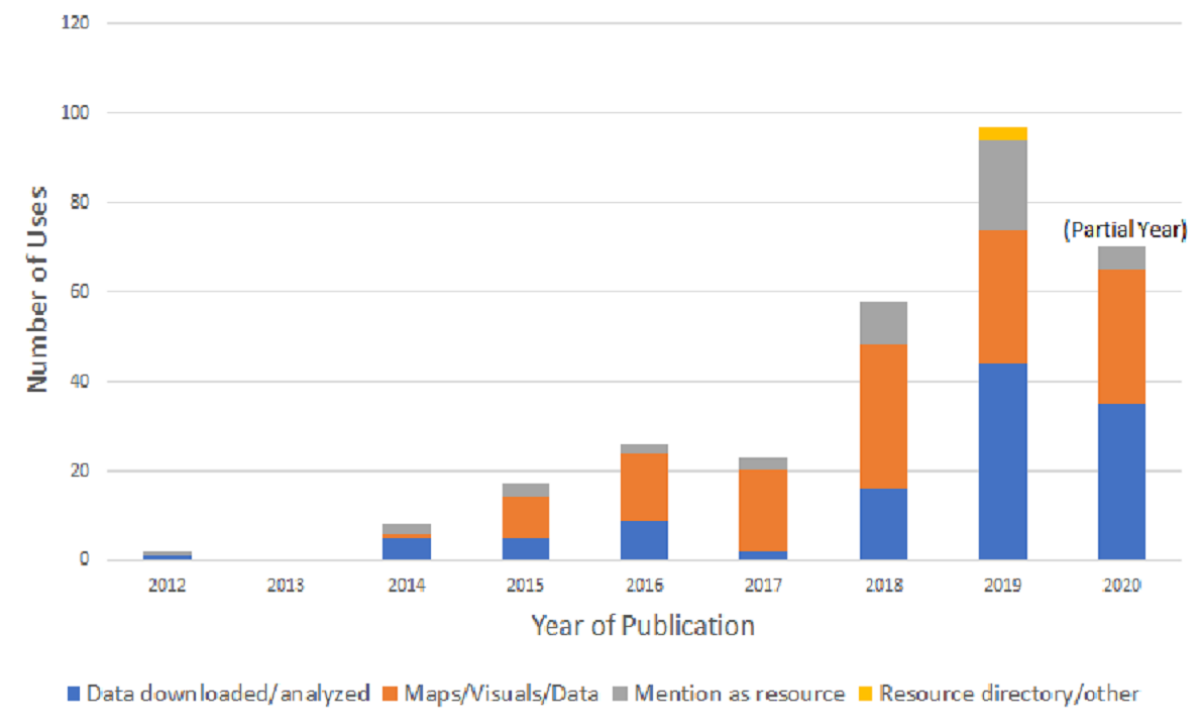
Figure 10. Number of academic uses of AIDSVu.org by year and use,